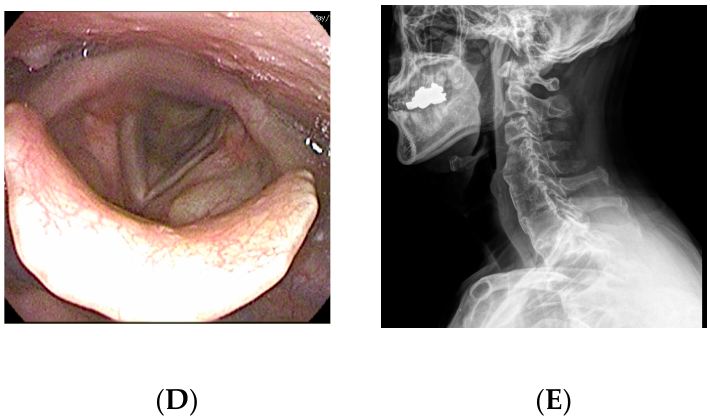
Figure 1. A 64-year-old man presented with swallowing difficulty for the past 2 months. ( A ) Preoperative laryngoscopy revealed a huge protruding mass at the posterior pharyngeal wall. ( B ) Lateral cervical radiograph showed continuous irregular hyperostosis along the anterior aspect of the cervical and upper thoracic vertebral bodies, suggesting diffuse idiopathic skeletal hyperostosis (DISH), with a beak-shaped osteophyte compressing the posterior pharynx. ( C ) Preoperative visual fluoroscopic swallowing study revealed moderate dysphagia in the oral and pharyngeal phases with incomplete closure of the epiglottis. ( D ) Postoperative laryngoscopy showed disappearance of the protruding mass at the posterior pharyngeal wall. ( E ) One-year postoperative radiograph showed no evidence of regrowth of the osteophyte.